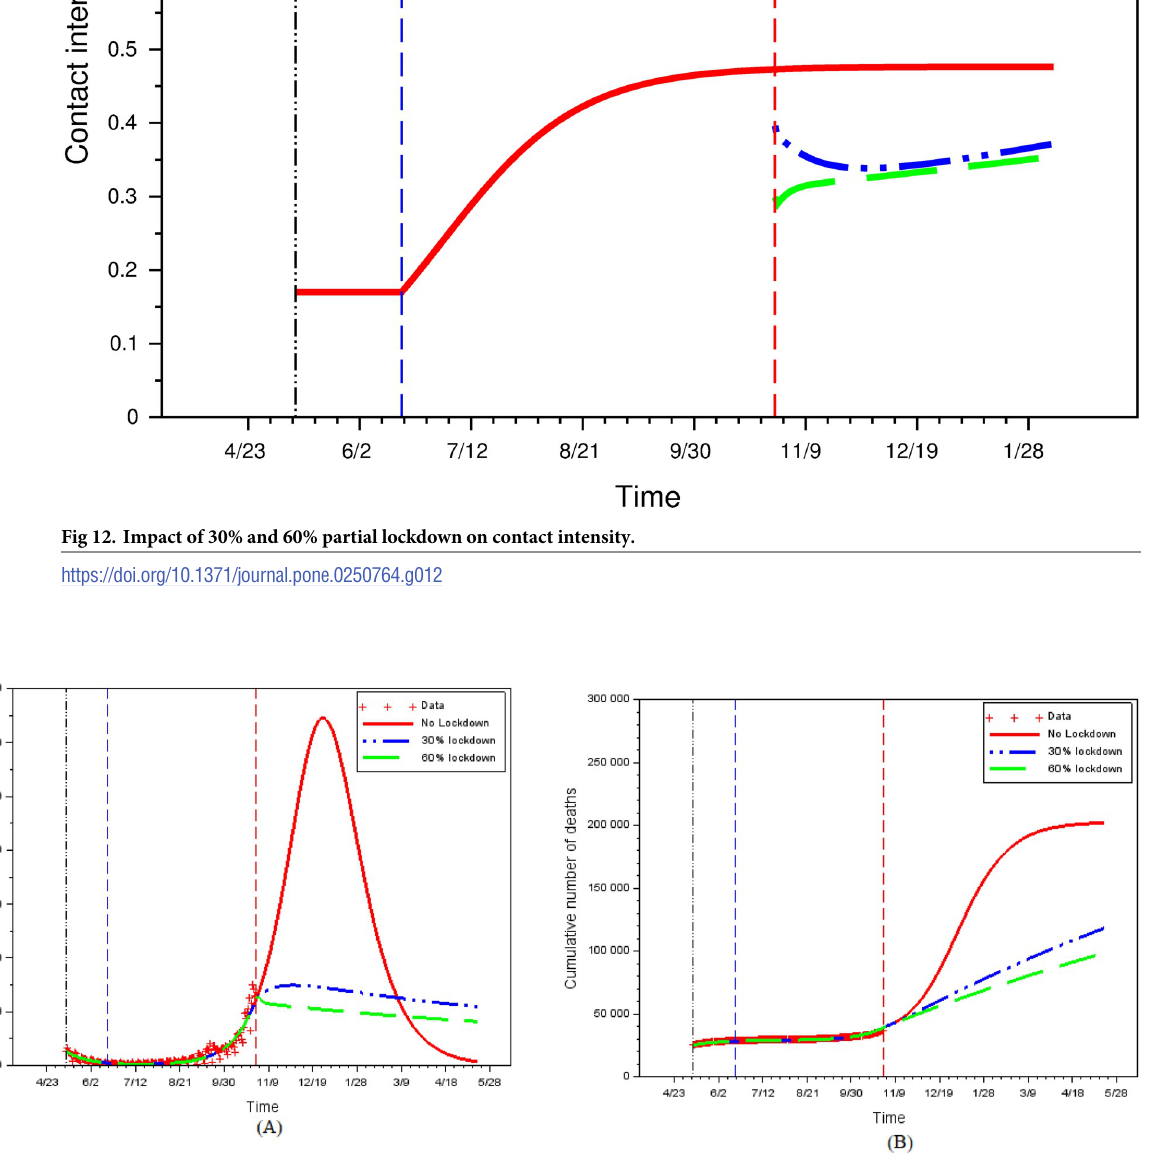
Fig 13. The impact of 30% and 60% partial lockdown. (A) Daily hospitalizations. (B) Cumulative number of deaths.